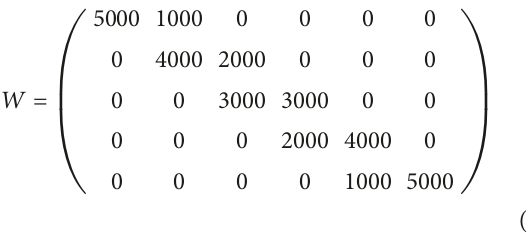
Figure 3: Patterns for cutting-and-welding six 5-meter pipes from five 6-meter